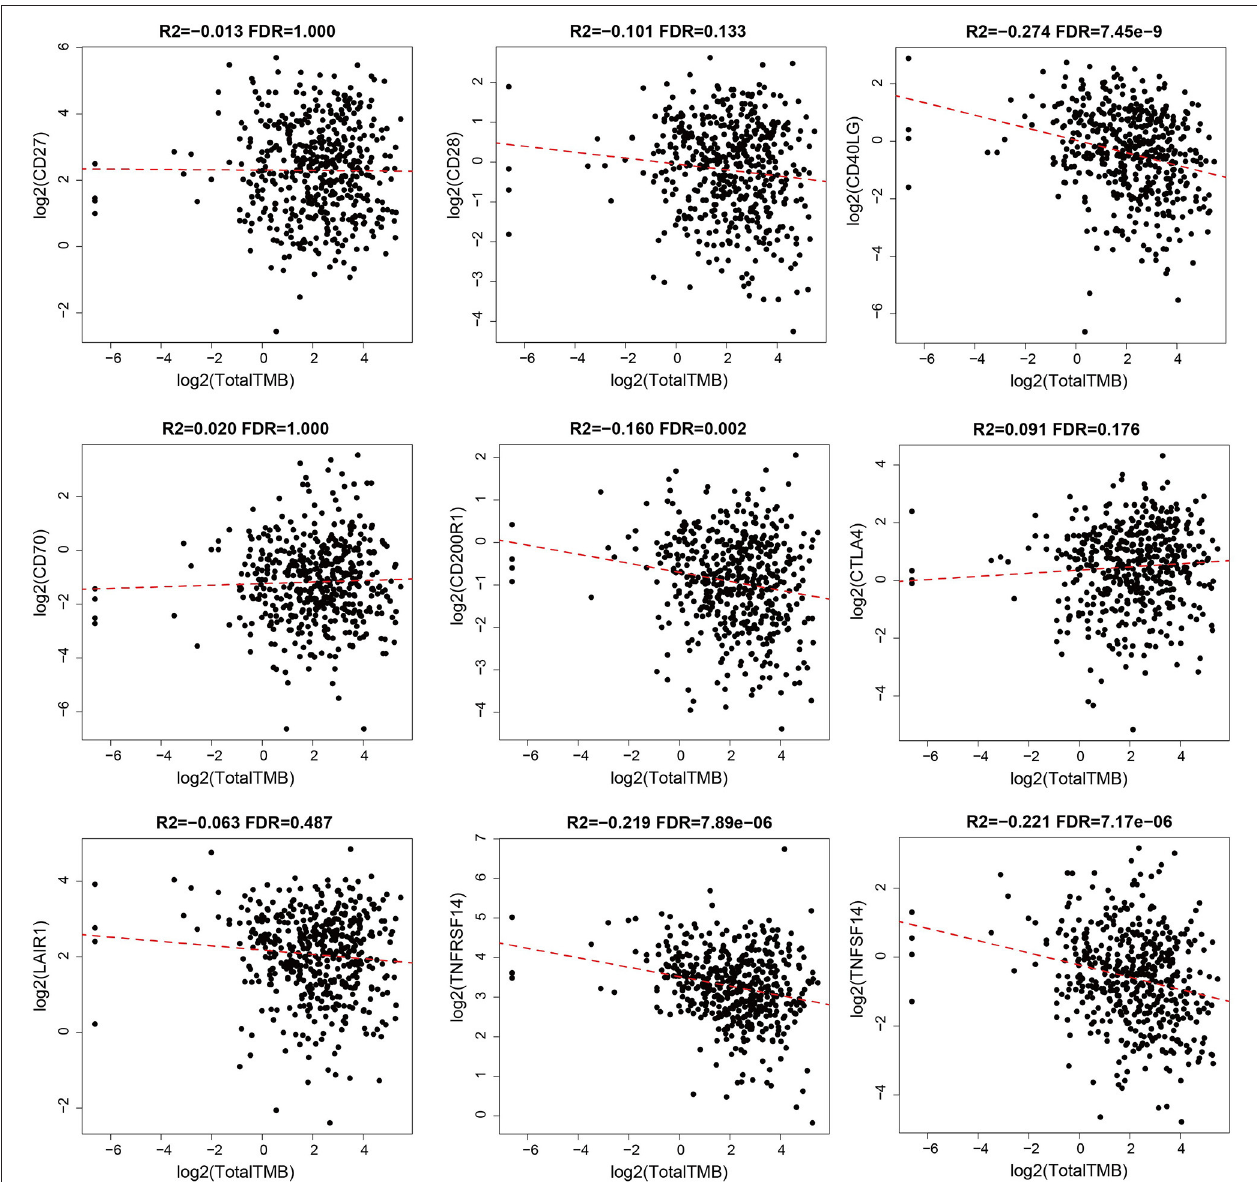
FIGURE 3 | Correlation scatter diagram of IGCs’ expression and tumor mutation burden (TMB). R2 is the correlation coefficient, and FDR is false discovery rate. The abscissa represents TMB, and the ordinate represents